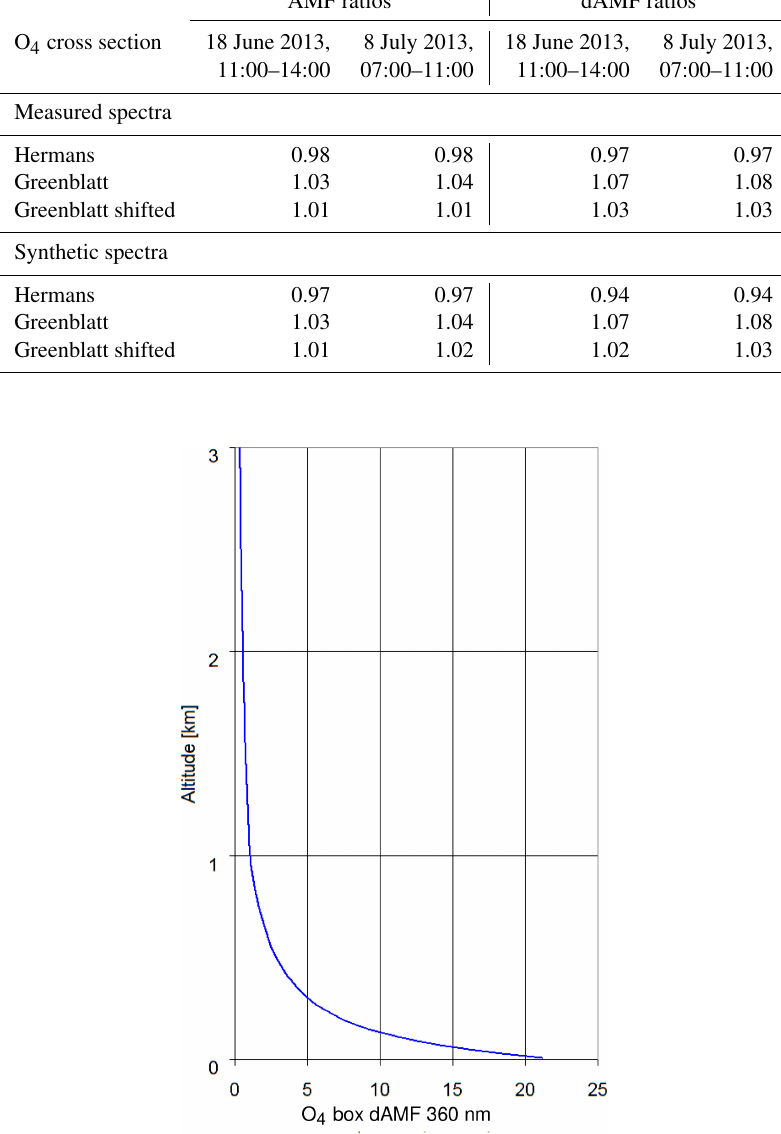
Figure A25. O 4 differential box AMFs (with 20m vertical resolution) used for the simulation of the temperature-dependent O 4 absorption spectra. They are averages of radiative transfer simulations for several scenarios. Simulations are performed for a surface albedo of 6%, aerosol profiles with constant extinction between 0 and 1000m and different AOD (0.1, 0.3, 0.7) and for all combinations of SZA (40, 60 ◦ ), RAZI (0, 90, 180 ◦ ) and elevation angles (2 and 3 ◦